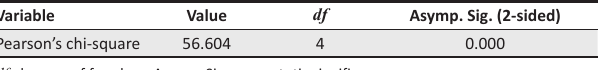
TABLE 2: Chi-square test of Hypothesis 1. Variable Value df Asymp. Sig. (2-sided) Pearson’s chi-square 56.604 4